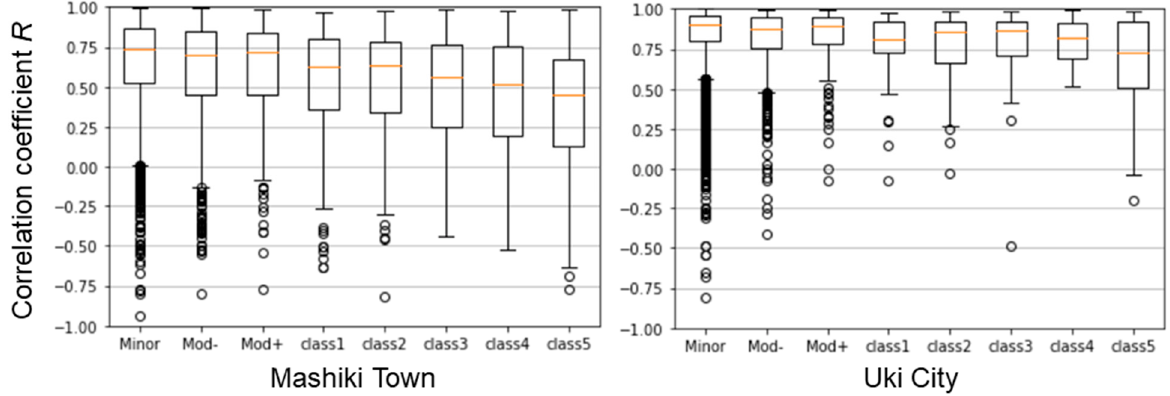
Figure 5. Box-and-whisker plots of the correlation coefficient of the backscatter coefficient R for each damage class.